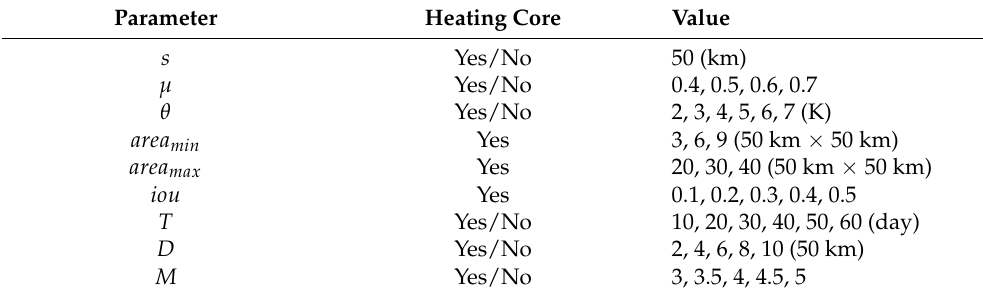
Table 4. Candidate parameters for models with and without a “heating core” when the moving window scale is